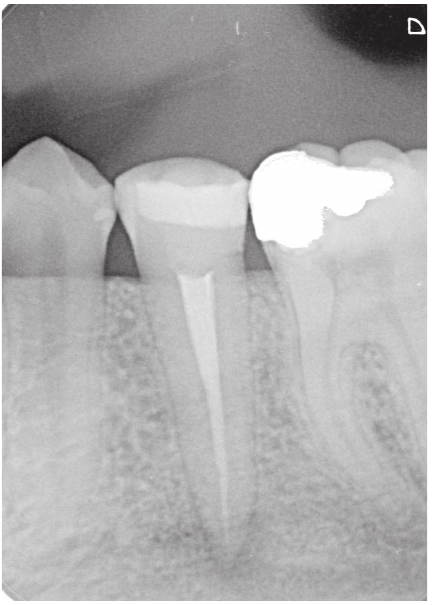
Figure 3: Periapical radiograph of mandibular left second premolar taken after root canal